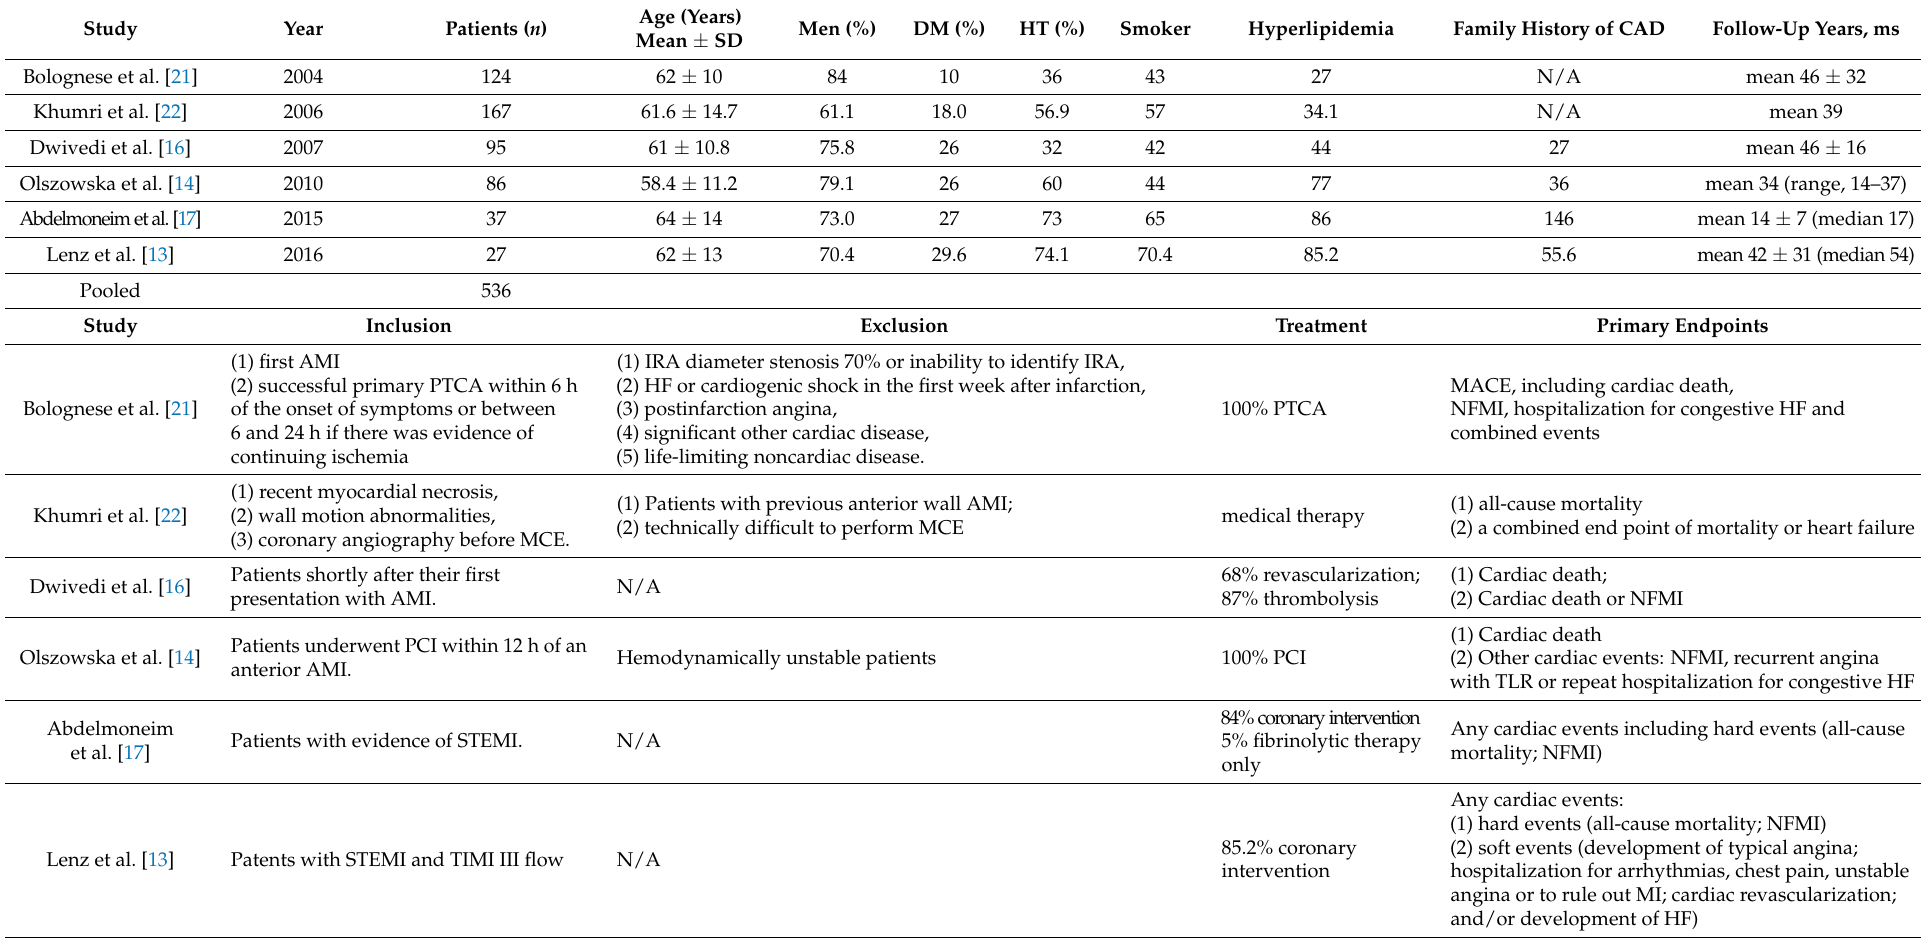
Table 1. Summary of basic characteristics of selected studies for